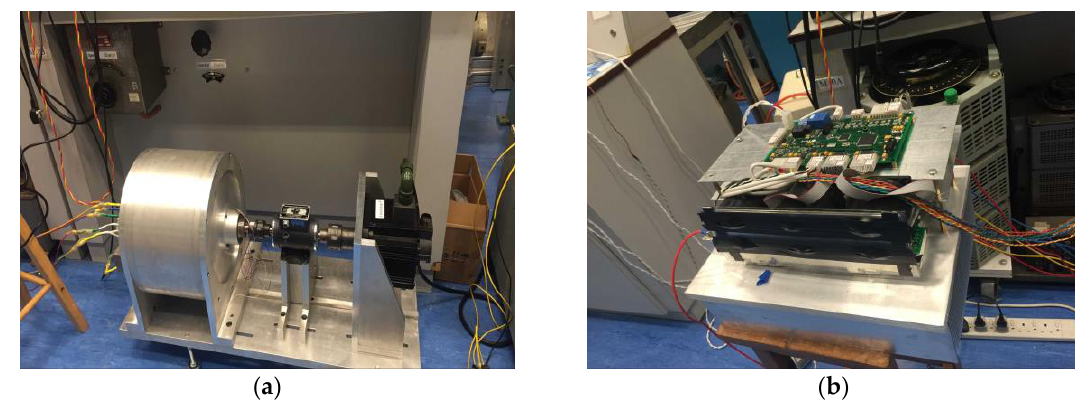
Figure 5. Prototype of the DSFM motor and its controller: ( a ) test machine; and ( b ) back-to-back controller. Table 1. DSFM motor prototype parameters and ratings.